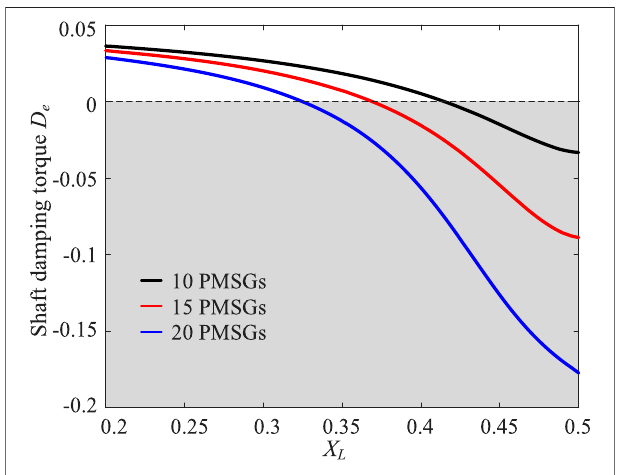
FIGURE 13 | Curve of D e with variation in X L under different number of PMSGs.